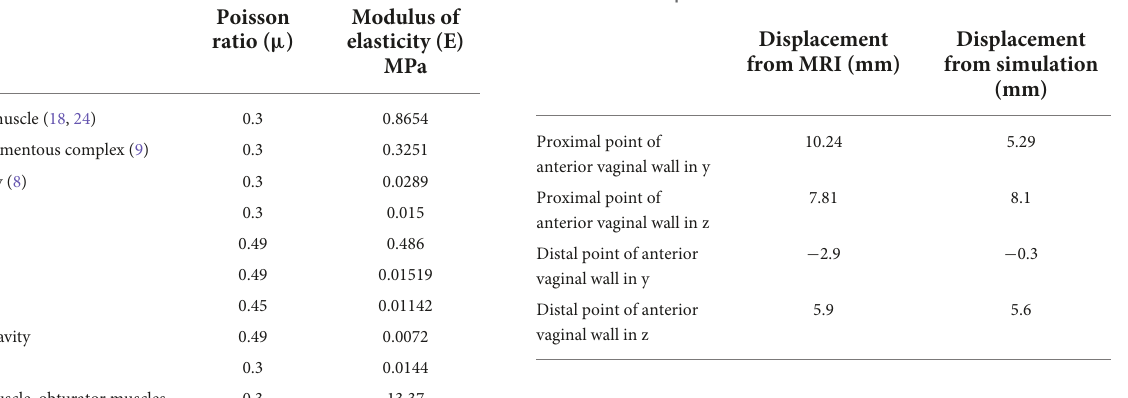
TABLE 1 Material parameters of pelvic tissue. TABLE 2 Comparison of vaginal displacement under high intra-abdominal